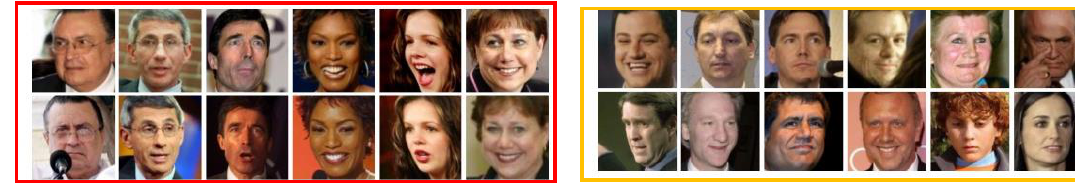
Figure 11. Example of images from the LFW (Labeled Faces in the Wild) dataset.lfw.